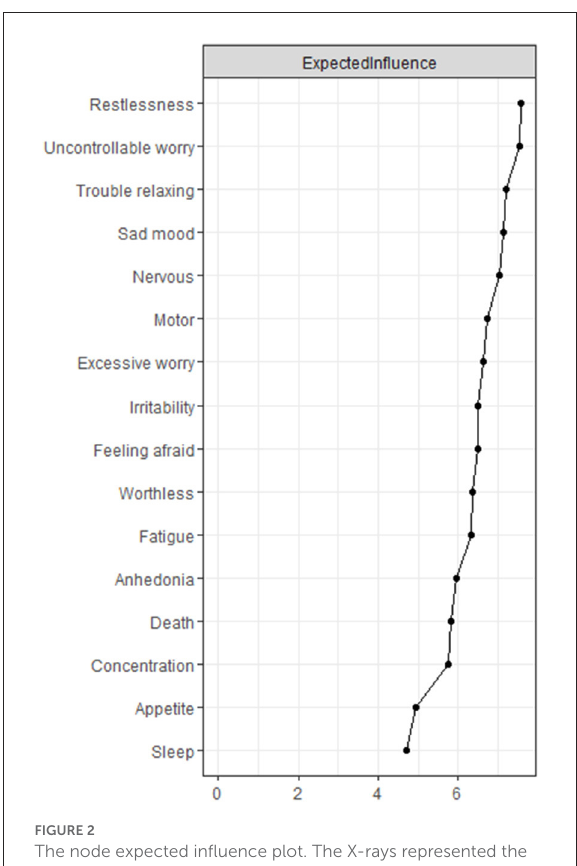
FIGURE2 The node expected influence plot. The X-rays represented the expected influence of each node. Nodes with higher expected influence have stronger impact in other nodes within the network.